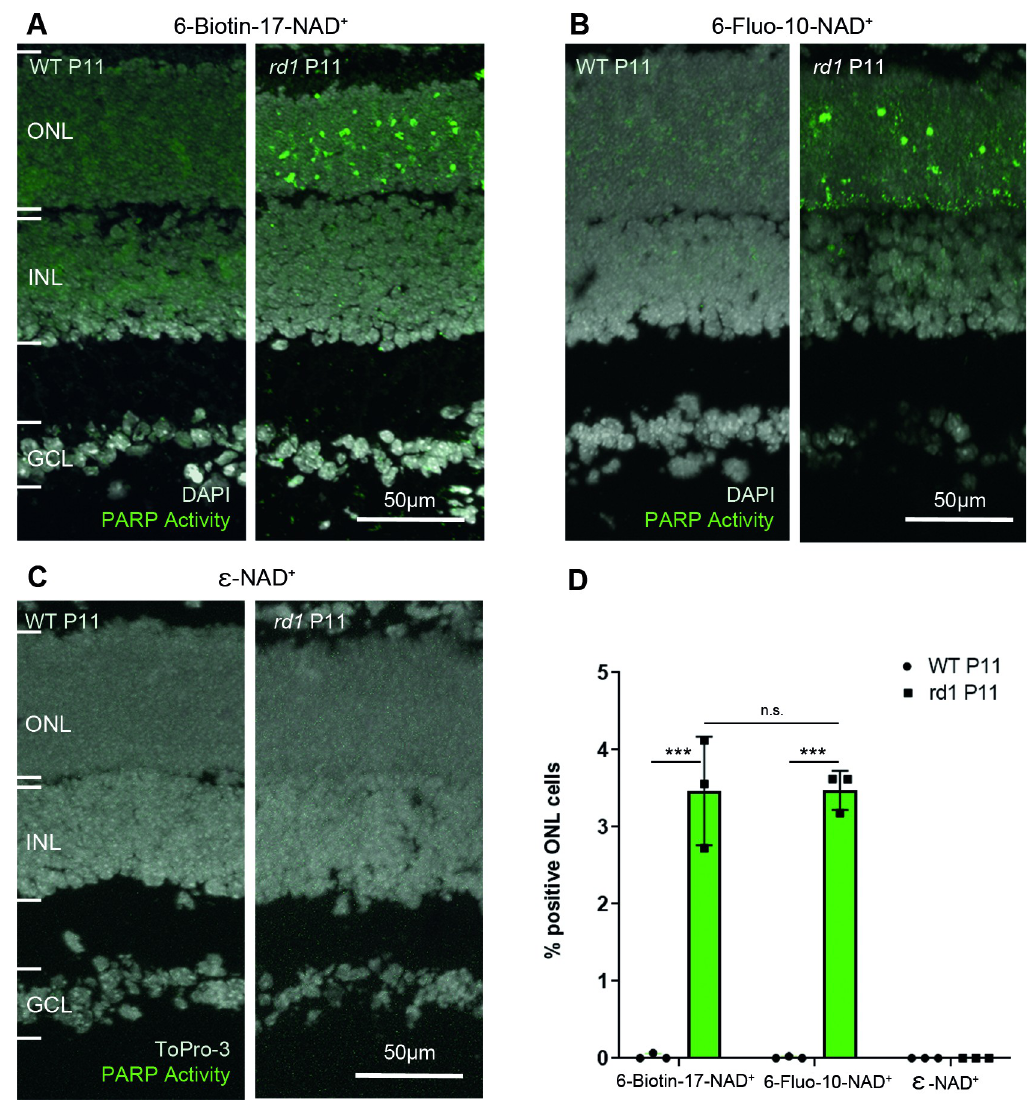
Fig 2. PARP activity detection with three different NAD + analogues, in wild-type and rd1 retina. Retinal tissue sections derived from either wild-type (WT) or rd1 animals, at post-natal (P) day 11, were incubated with different NAD + analogues. ( A ) In the two-step assay, employing 6-Biotin-17-NAD + , PARP activity positive cells were rarely seen in the WT retina but readily detected in the rd1 outer nuclear layer (ONL). ( B ) The single-step assay with 6-Fluo-10-NAD + detected similar numbers of PARP activity positive cells in the rd1 ONL. ( C ) No PARP activity was observable with the assay employing ε -NAD + and a standard UV band-pass filter intended for DAPI visualization. ( D ) Quantification of PARP activity positive cells in WT and rd1 ONL in assays using the three different NAD + analogues. DAPI was used as nuclear counterstaining in A and B; To-Pro-3 was used in C. PARP assays performed on tissue sections derived from at least three different WT and rd1 animals (n = 3); error bars indicate STD; statistical analysis: two-way ANOVA with multiple comparison. INL = inner nuclear layer, GCL = ganglion cell layer. When 6-Fluo-10-NAD + was used as a substrate for PARP, a high amount of PARP positive cells was observed in the ONL of rd1 P11 sections. Some signal was also seen at the lower bor- der of the ONL, close to the outer plexiform layer (OPL) (Fig 2B). In contrast, ε -NAD + did not reveal any PARP specific signal, neither in rd1 tissue sections, nor in WT ones, when visualized with a standard UV band-pass filter for DAPI (Fig 2C, cf . Table 1).